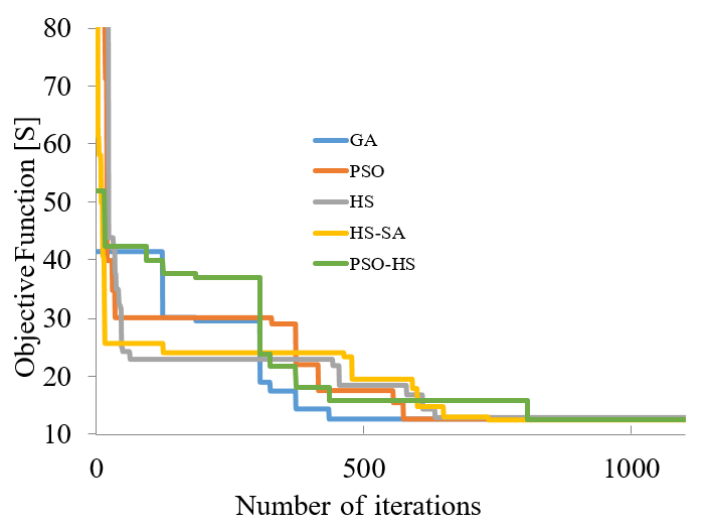
Figure 6. Convergence of different algorithms for Scenario 3.